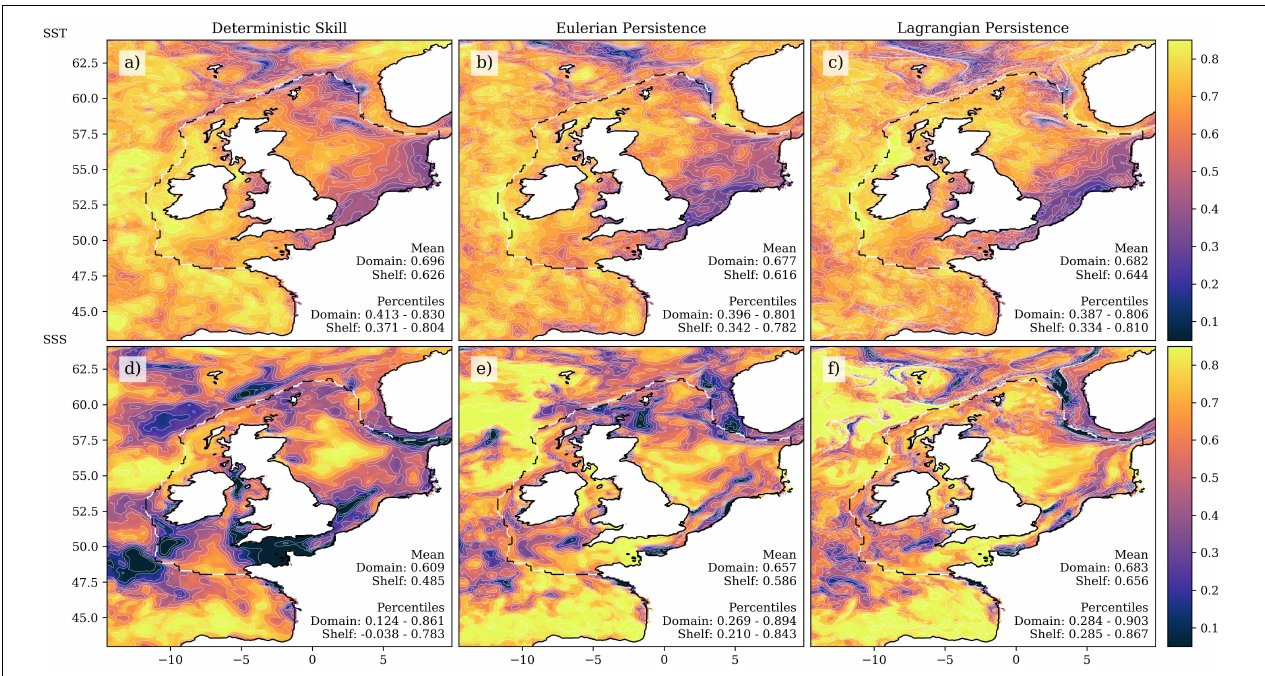
FIGURE 6 | Deterministic skill (a,d) and Persistence [Eulerian (b,e) and Lagrangian (c,f) ] for SST (a–c) and SSS (d–f) . The black and white dashed line delineates the NWS shelf region. Spatial statistics, including the mean value, and the range of values at the 5th and 95th percentiles, are given in each panel.